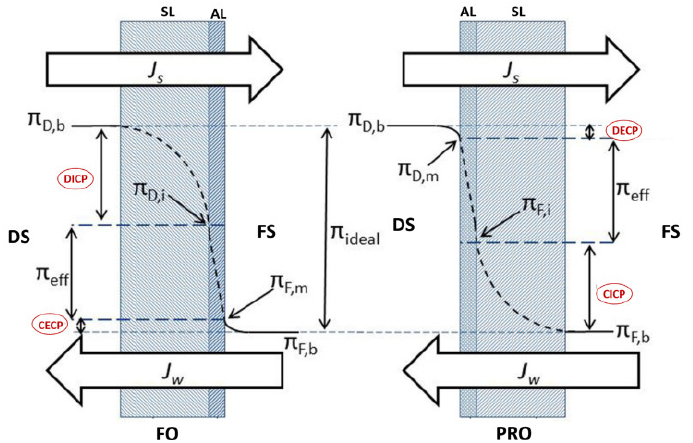
Figure 7. Internal and external concentration polarization types [27].